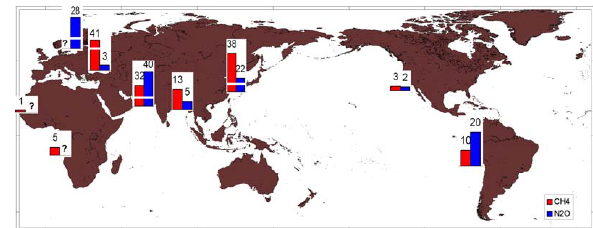
Fig. 5. Sea to air emission flux of CH 4 and N 2 O (unit:µmolm − 2 d − 1 ) from major coastal hypoxic environments of the world, including upwelling systems (i.e. Canary Current, Benguela Current, California Current, and Humboldt Current), Northern Indian Ocean (i.e. Arabian Sea and Northern Bay of Ben- gal), semi-enclosed basins (e.g. Black Sea and Baltic Sea), and off large river mouths and in adjacent shelves (e.g. Changjiang Estuary and East China Sea Shelf). See Table 2 for details of data source. For comparison, CH 4 and N 2 O concentrations in the open ocean not underlain by oxygen-depleted waters are close to or slightly super- saturated (i.e. by a few percent) with reference to their atmospheric